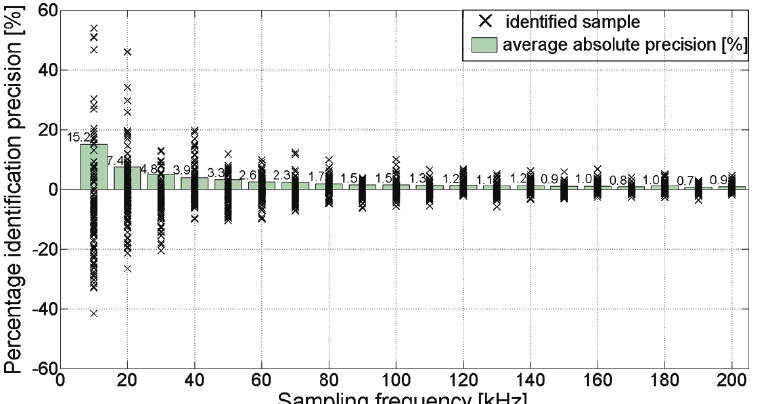
Fig. 14. Error of mass identi fi cation as a function of sampling frequency.